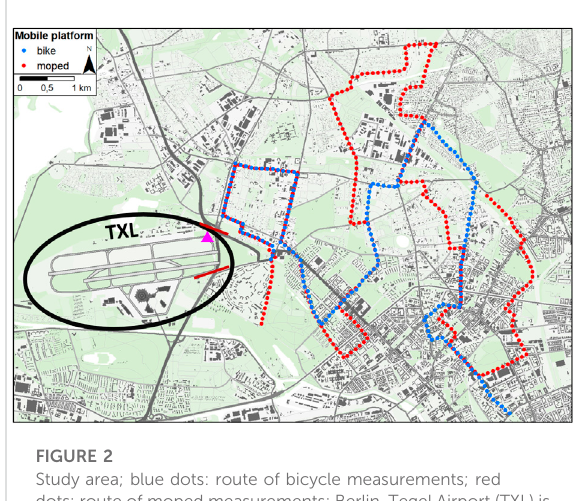
FIGURE 2 Study area; blue dots: route of bicycle measurements; red dots: route of moped measurements; Berlin-Tegel Airport (TXL) is marked with black ellipse. Between the two red lines, the highway (dark gray line) leads through an underground tunnel in the east of TXL. Pink triangle: weather station of Germany ’ s National Meteorological Service (DWD). Data basis: Environmental Atlas